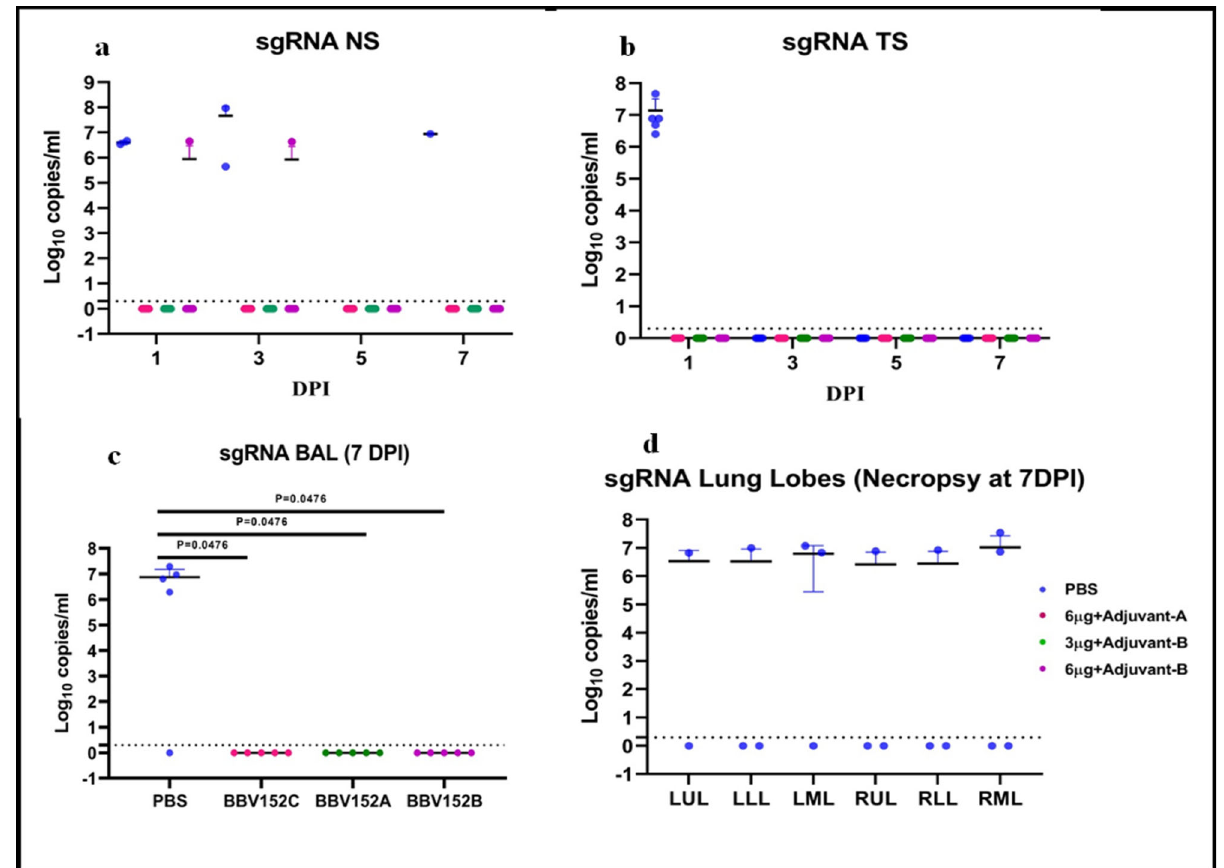
Fig. 4 Subgenomic viral RNA detection in the respiratory tract specimens. sgRNA load in ( a ) BAL at 7 DPI, ( b ) sgRNA in different lobes of lungs at 7 DPI, ( c ) throat swab at 1 DPI and ( d ) sgRNA load in NS at 1, 3, 5 and 7 DPI. The statistical signi fi cance was assessed using the Kruskal – Wallis test followed by the two-tailed Mann – Whitney test between the two groups; P values < 0.05 were considered to be statistically signi fi cant. The dotted lines indicate the limit of detection of the assay. Data are presented as mean values + / − standard deviation (SD). Statistical comparison was done by comparing the vaccinated group with the placebo group as a control. Group I = blue, group II = pink, group III = green and group IV = purple, number of animals = 5 animals in each group. Source data are provided as a Source Data fi